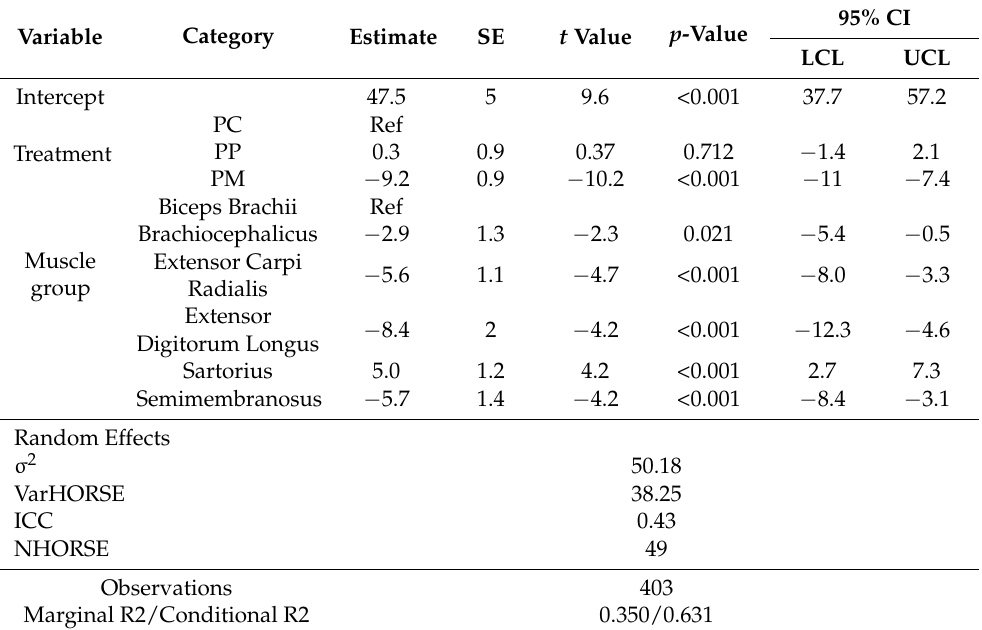
Table 4. Linear Mixed Effects Model for assessing the effect of treatment and muscle group on tissue oxygen saturation